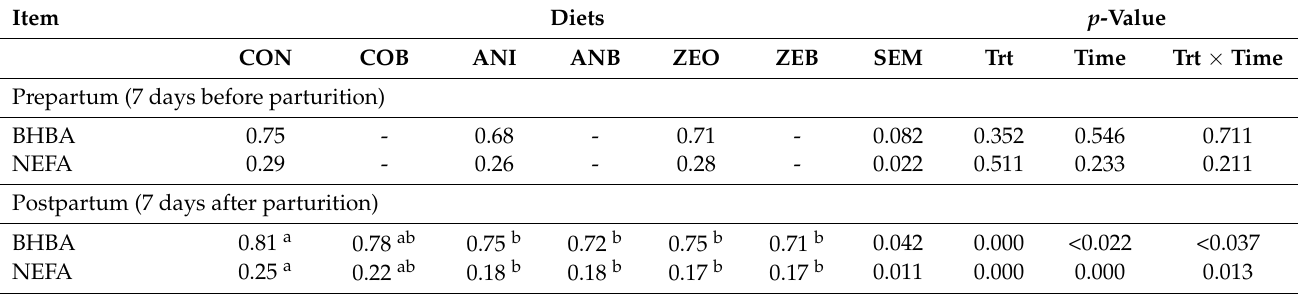
Table 6. Effect of experimental diets on blood metabolites of the